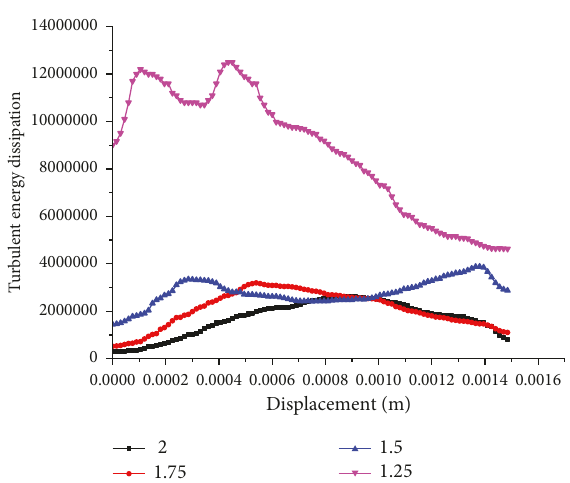
Figure 16: Turbulent energy distribution at the sudden extension of cross section. Figure 17: Velocity distribution in the recirculation zone of vortex core